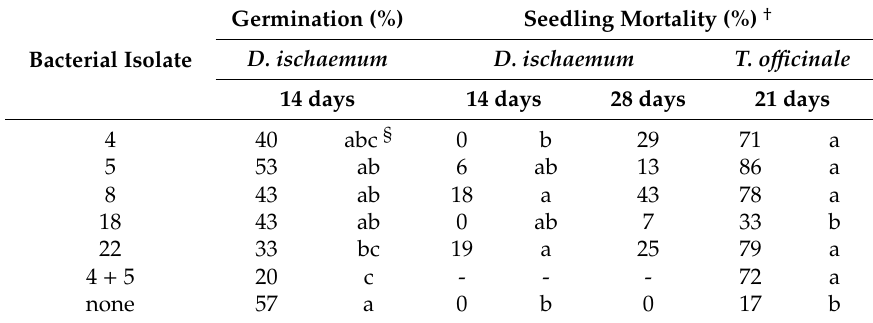
Table 3. Effect of Pantoea spp. isolates on Digitaria ischaemum germination and seedling mortality 14 and 28 days after inoculation in axenic agarose culture. Ten seeds were placed in each Petri dish and each treatment was replicated in three Petri dishes. Taraxacum officinale seeds were also inoculated in separate Petri dishes and included for comparison; mortality was evaluated at 21 days after treatment. Germination (%) Seedling mortality (%) † Bacterial isolate D. ischaemum D. ischaemum T. officinale D. ischaemum D.